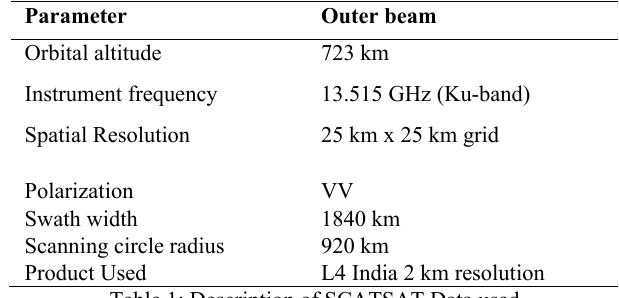
Table 1: Description of SCATSAT Data